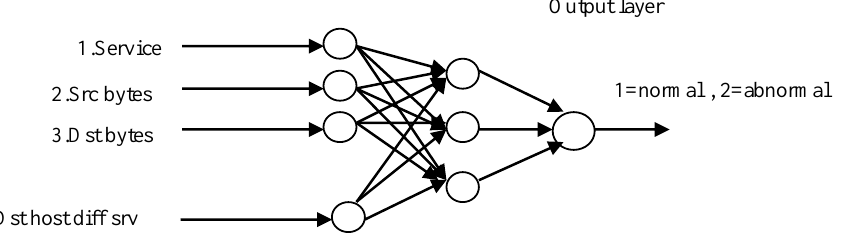
Figure 2. Structure of a neuron.